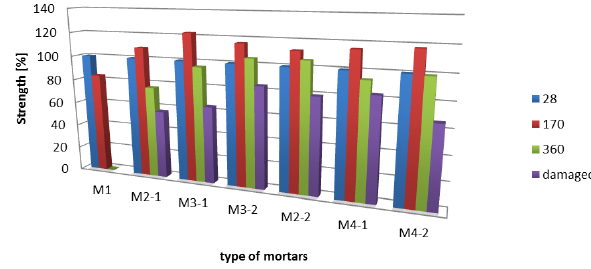
Figure 4: Strength for the mortars expressed as percentage at 28 days for each mortars